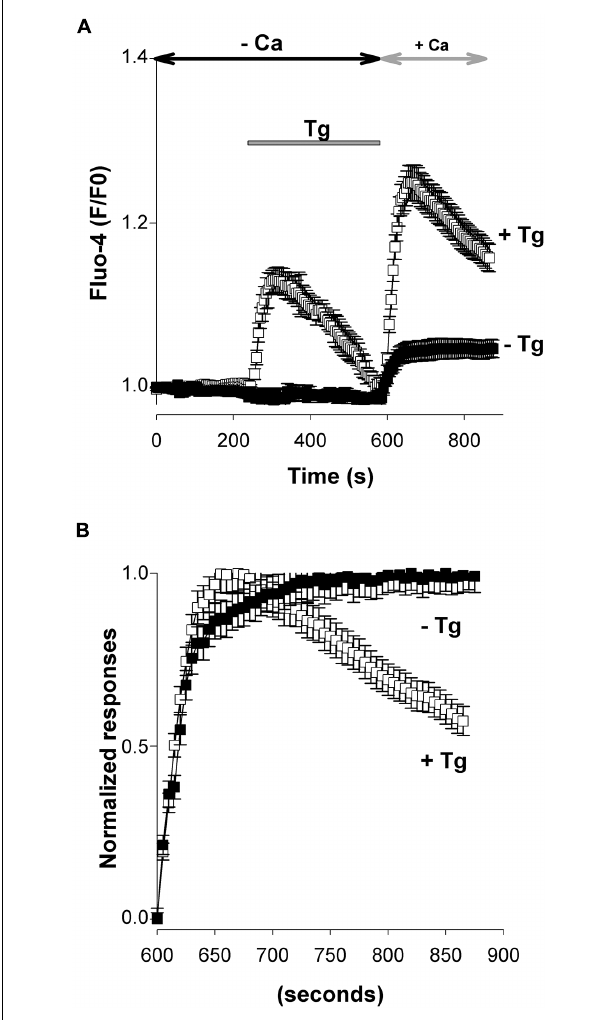
FIGURE 6 | Resting Ca 2 + entry and SOCE. (A) Same protocol as in Figure 2 . Some neurons were challenged with Tg (200 nM, open squares, n = 101 cells) to elicit a SOCE. In another set of experiments, Tg was omitted (filled squares, n = 139 cells). (B) Same data as in ( A ; from time + 600 to 875 s) after the re-admission of Ca 2 + (2 mM) into the external recording saline. Signals have been normalized. Mean ±